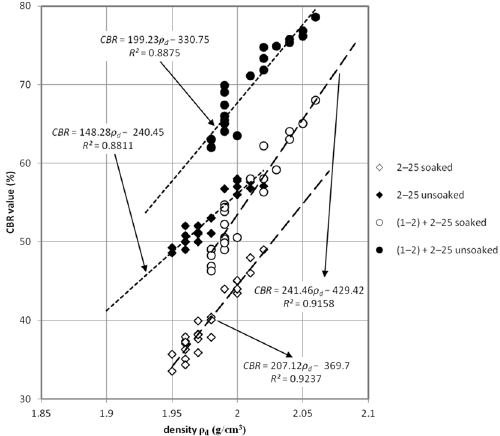
Figure 2. Bearing capacity tests for steel slag mixture aggregate with various grain size and curing conditions.